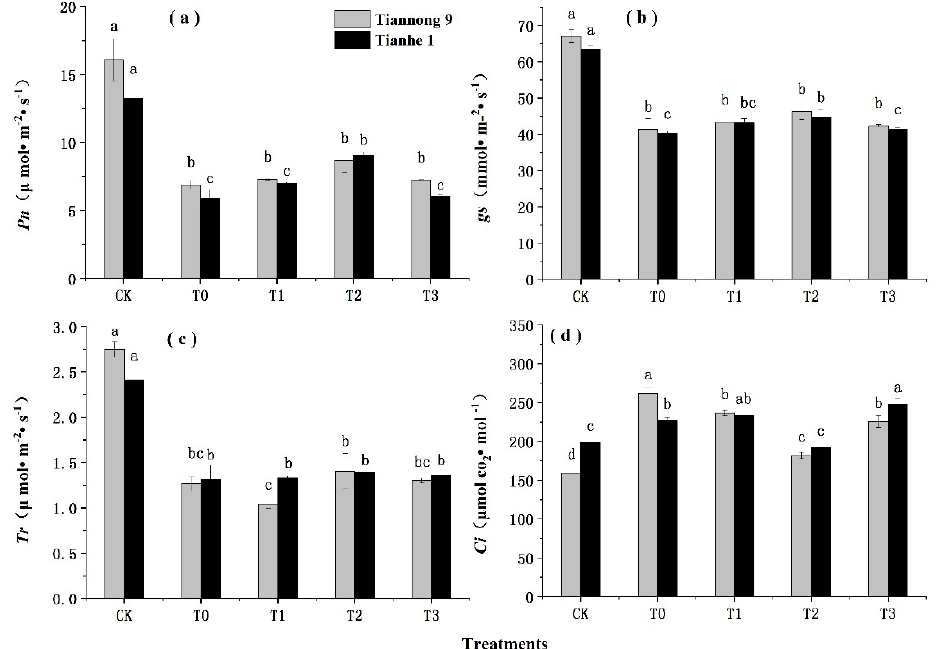
Figure 3. Effects of different concentrations of BL on photosynthesis of maize seedlings under chilling stress. CK treatment at 25 °C with distilled water, T0 treatment with BL at 0.00 mg/L, T1 treatment with BL at 0.01 mg/L, T2 treatment with BL at 0.1 mg/L, T3 treatment with BL at 1 mg/L. The data represent the means of independent measurements with three replicates. The mean values marked with different letters differ significantly at p < 0.05. ( a ) The variation trend of Pn. ( b ) The variation trend of gs. ( c ) The variation trend of Tr. ( d ) The variation trend of Ci.